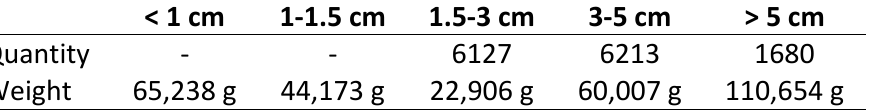
Table 5. Classification by length and total weight of the working debris from the manufacture of grinding stones.